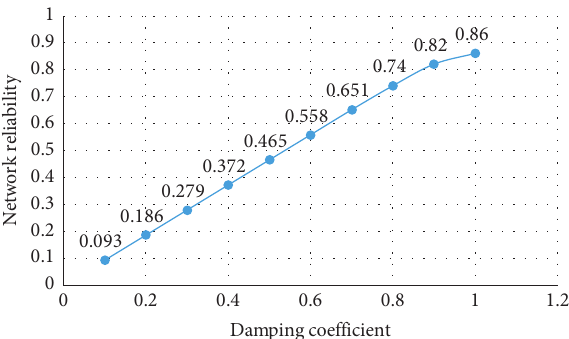
Figure 7: Network reliability vs. damping coefficient.